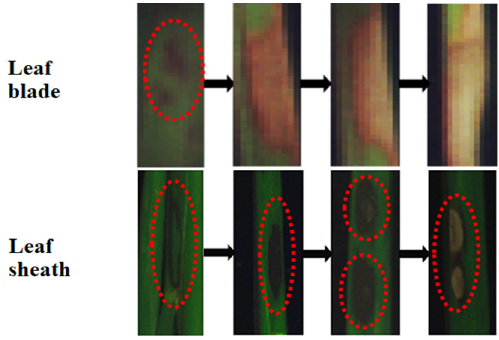
Figure 1. Symptom development of sheath blight (ShB) on the rice leaf blade and the leaf